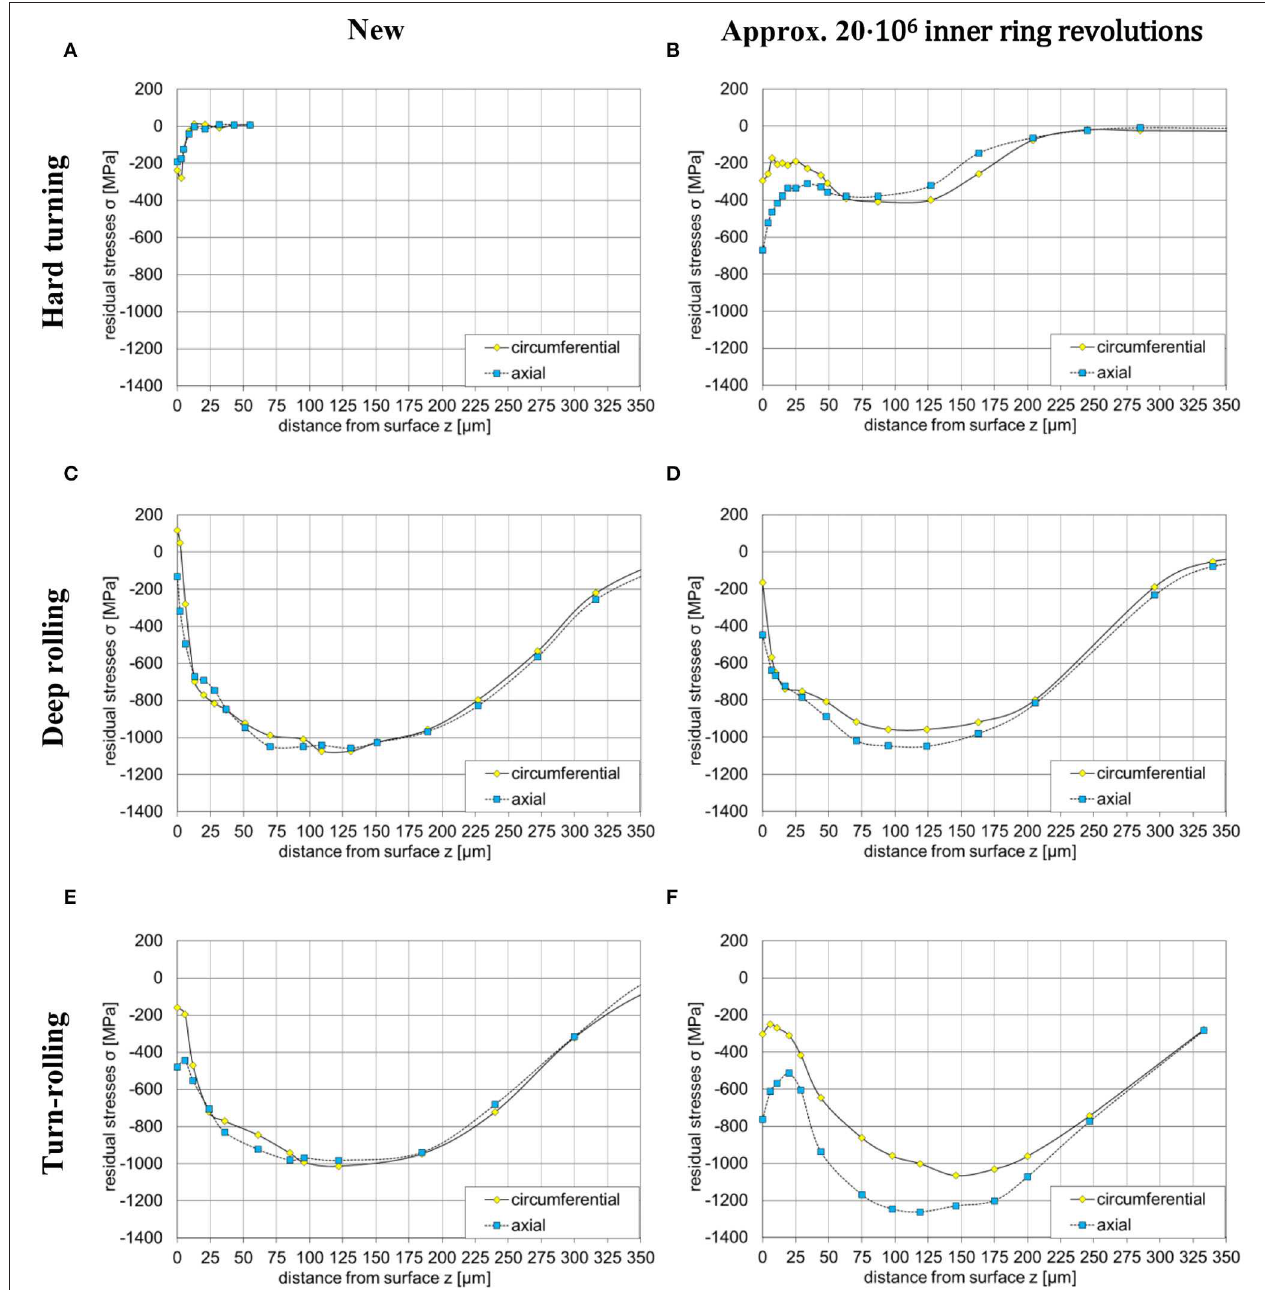
FIGURE 6 | Measured residual stresses in circumferential and axial directions for various manufacturing strategies after different phases, (A) hard turned bearing in new state, (B) hard turned bearing after test, (C) deep rolled bearing in new state, (D) deep rolled bearing after test, (E) turn rolled bearing in new state, (F) turn-rolled bearing after